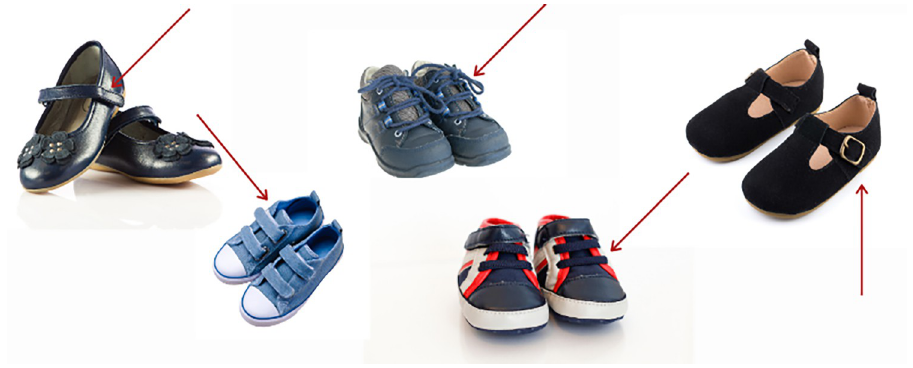
Fig 2. Footwear features